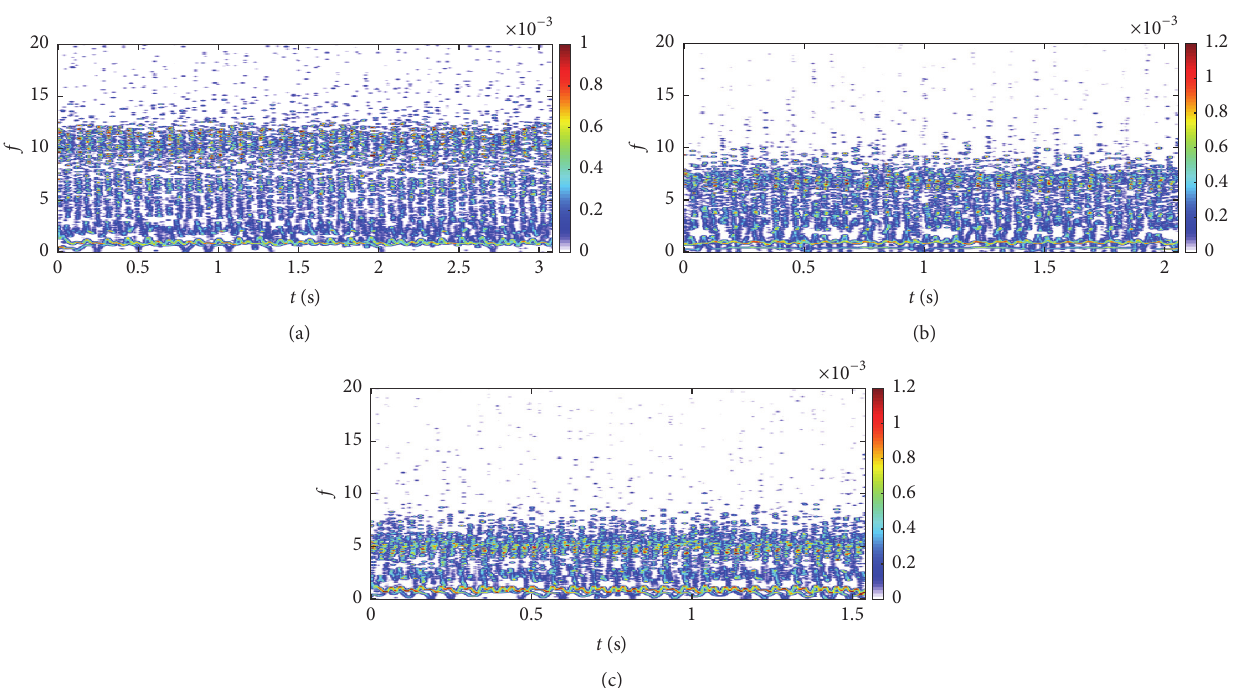
Figure 18: The time-frequency diagrams of the system with the SFD mounted on the normal bearing at (a) 100 rad/s and (b) 150 rad/s and (c) 200 rad/s.